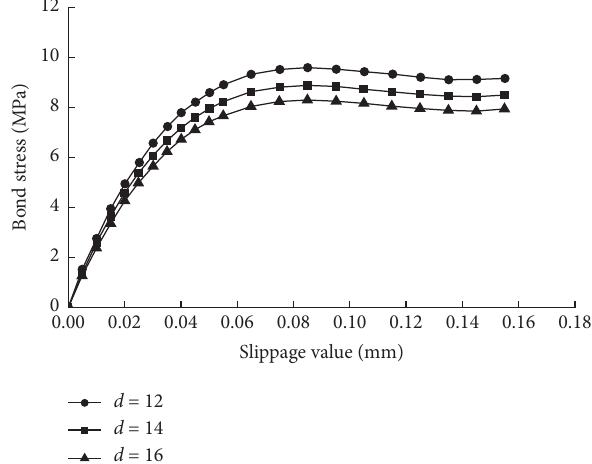
Figure 4: Stress-strain relationship between ribbed steel bar and concrete.